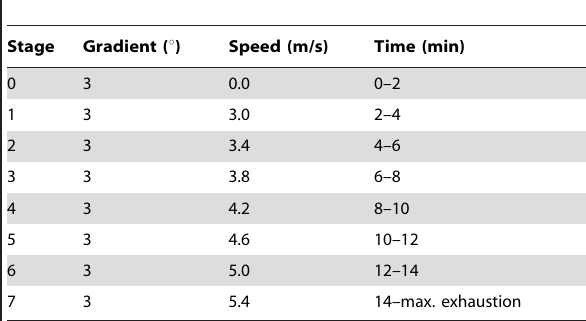
Table 2. Protocol of exercise